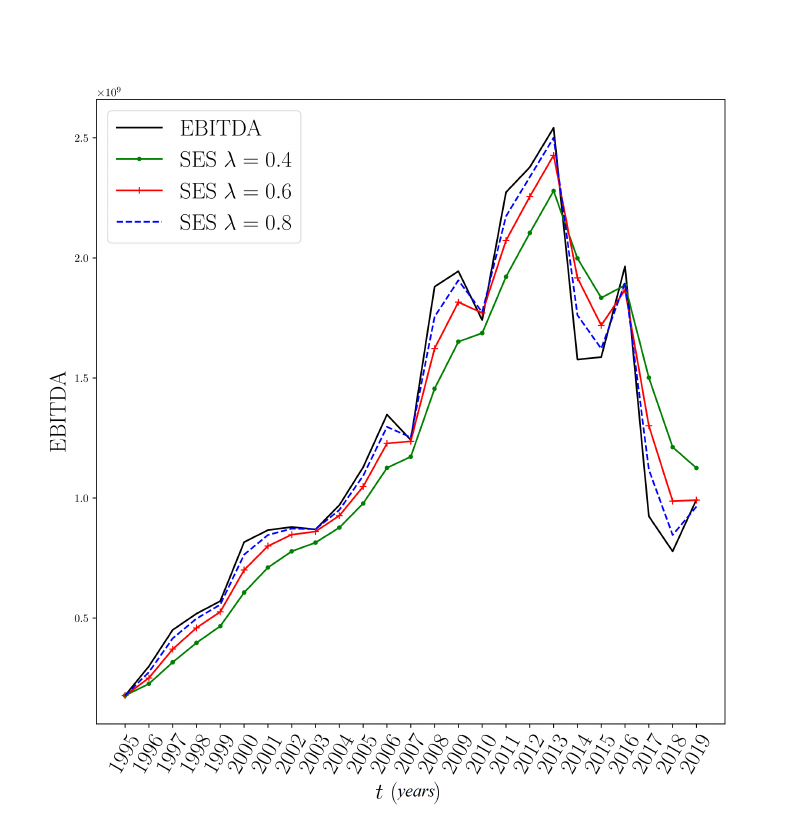
Figure 2. SES model for the EBITDA index with λ =